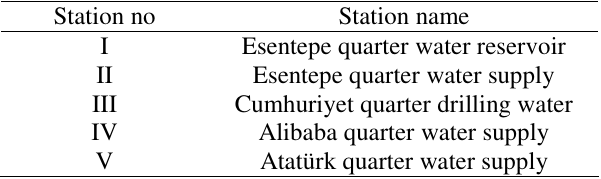
Table 1. List of the sampling stations